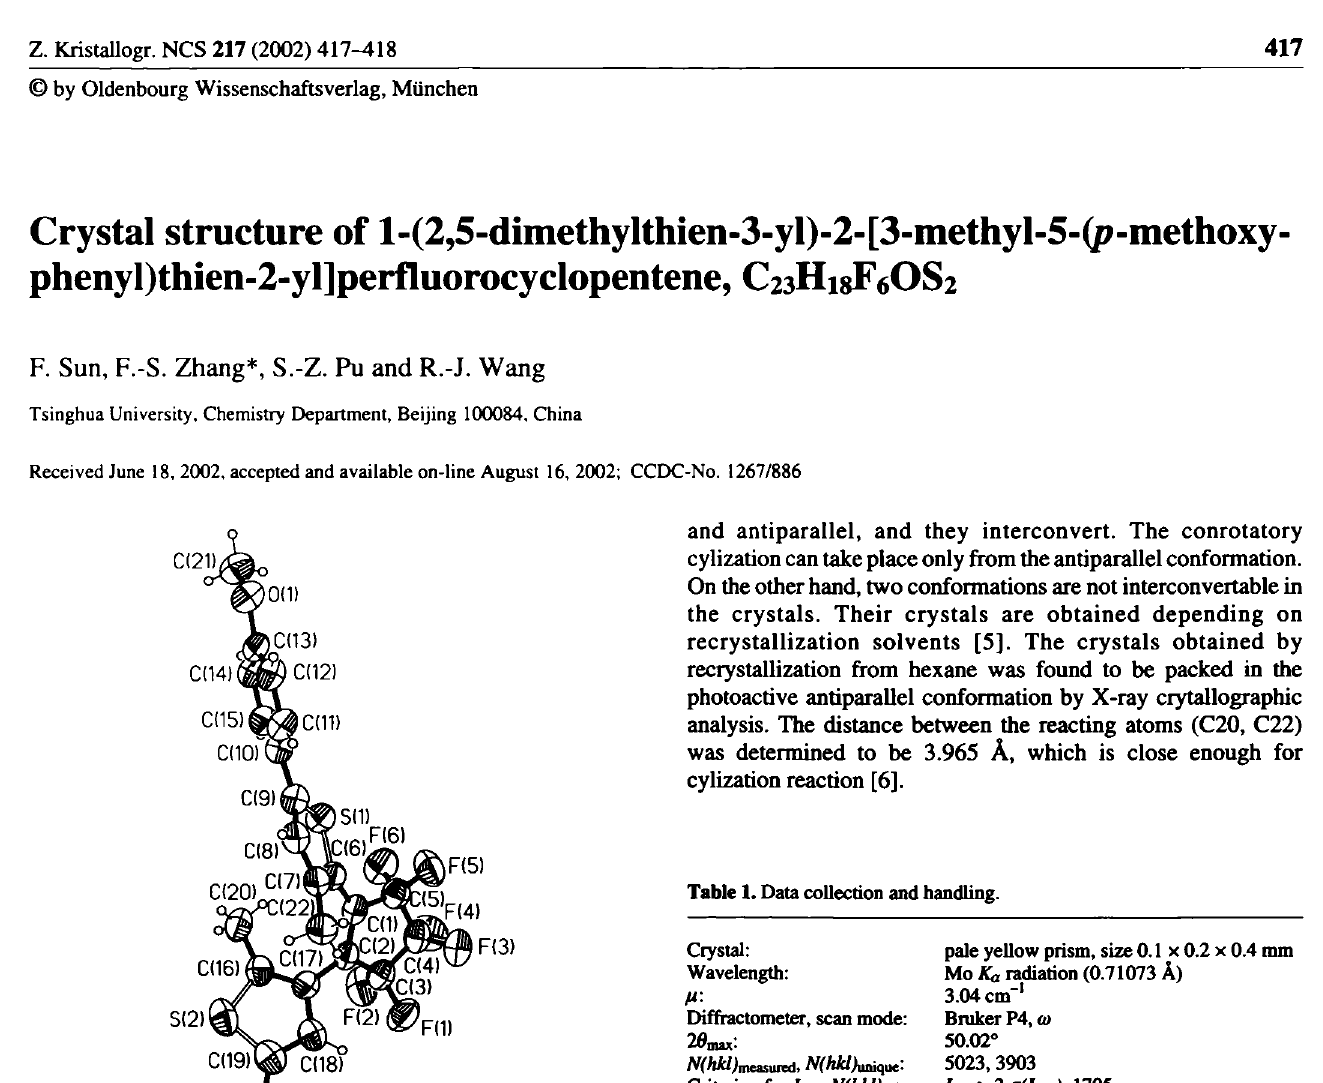
Table 2. Atomic coordinates and displacement parameters (in Â 2